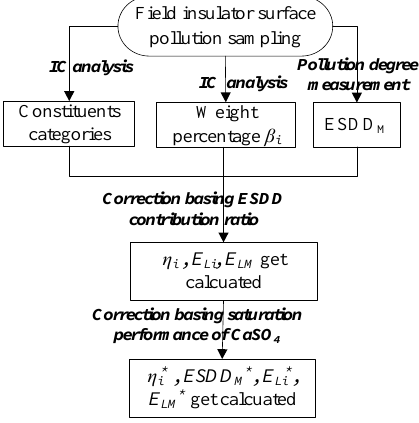
Figure 6. Flashover voltage gradient correction procedure for natural polluted insulator.